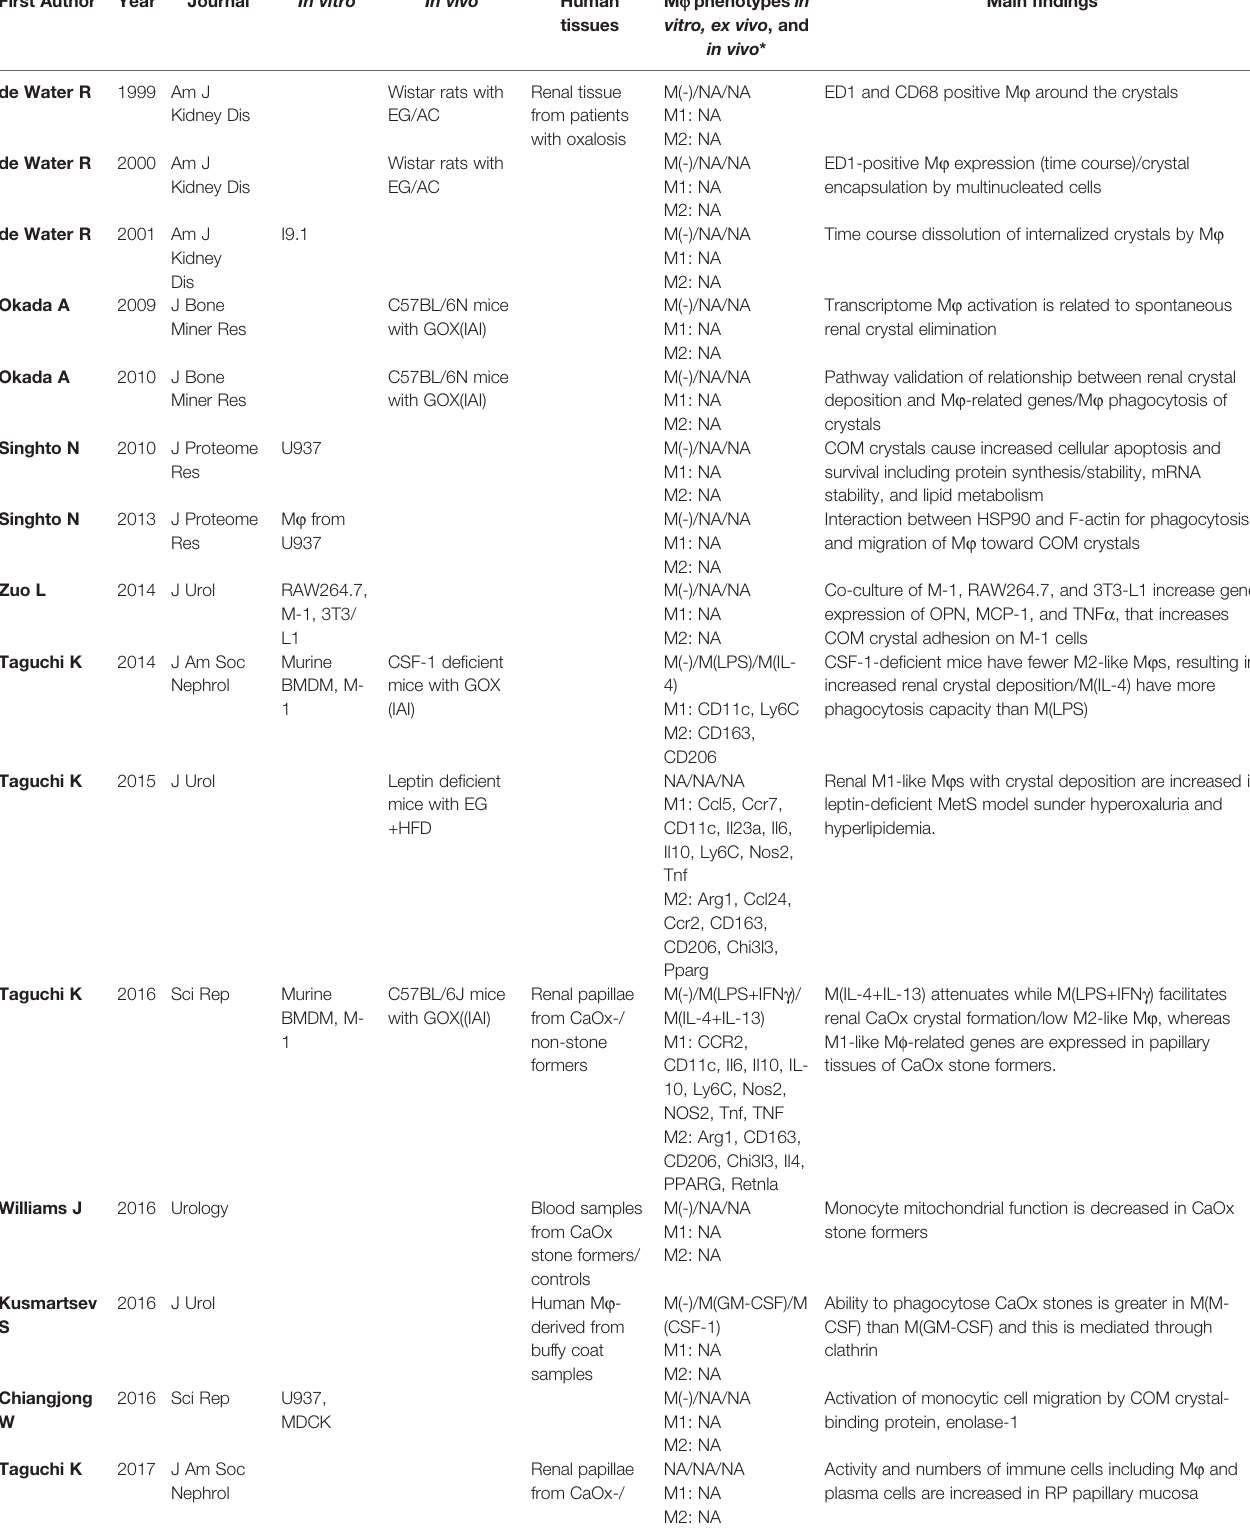
TABLE 1 | Summary of systematically reviewed